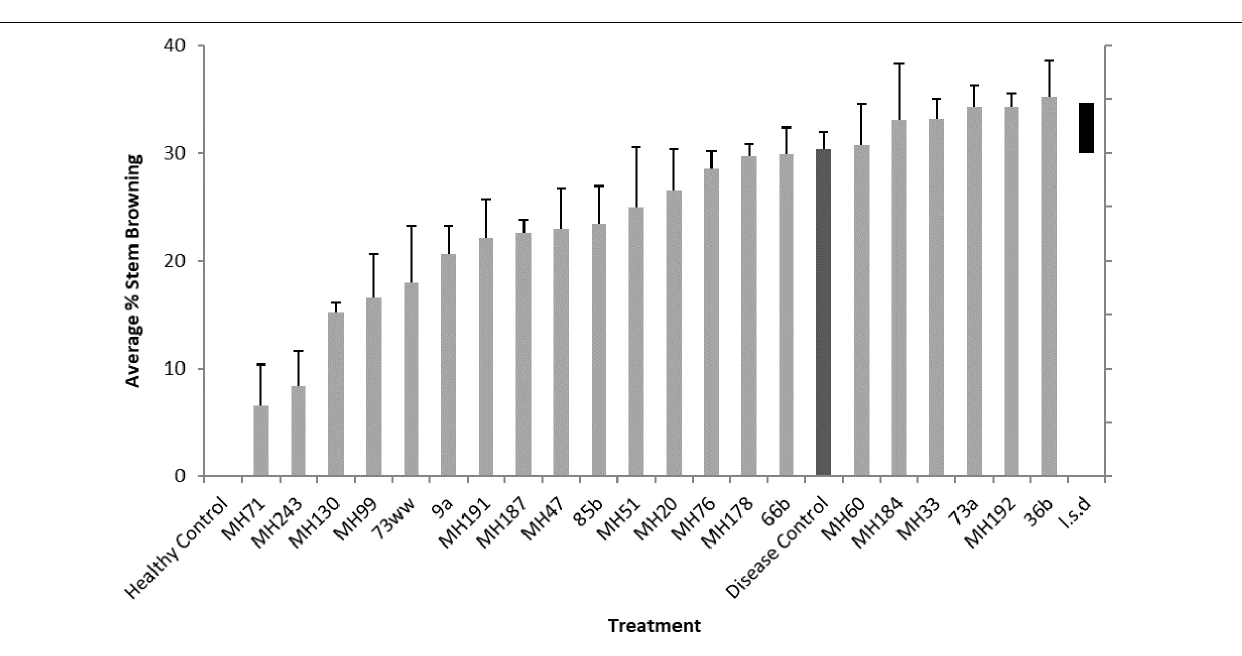
FIGURE 6 | Crown rot symptoms (% stem browning) observed on seedlings grown from seeds coated with Actinobacteria isolates and inoculated with F. pseudograminearum CS5642. L.s.d denotes least significant difference (at P = 0.05) in expression of disease (% stem